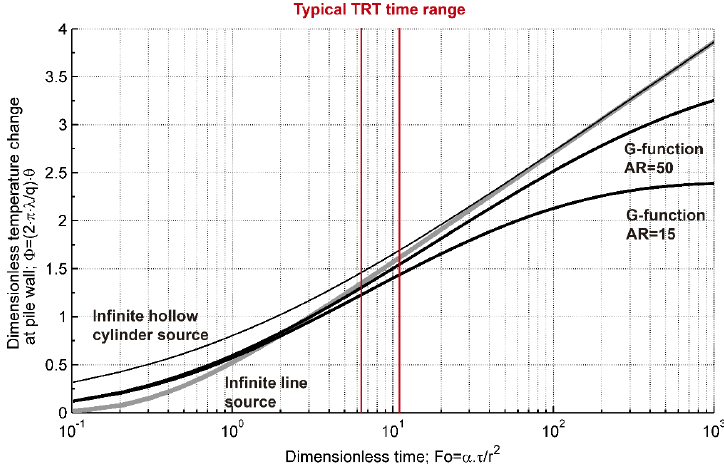
Figure 18. Line source solutions together with pile heat exchanger G-functions [154] for different aspect ratios (AR) and typical TRT time ranges.